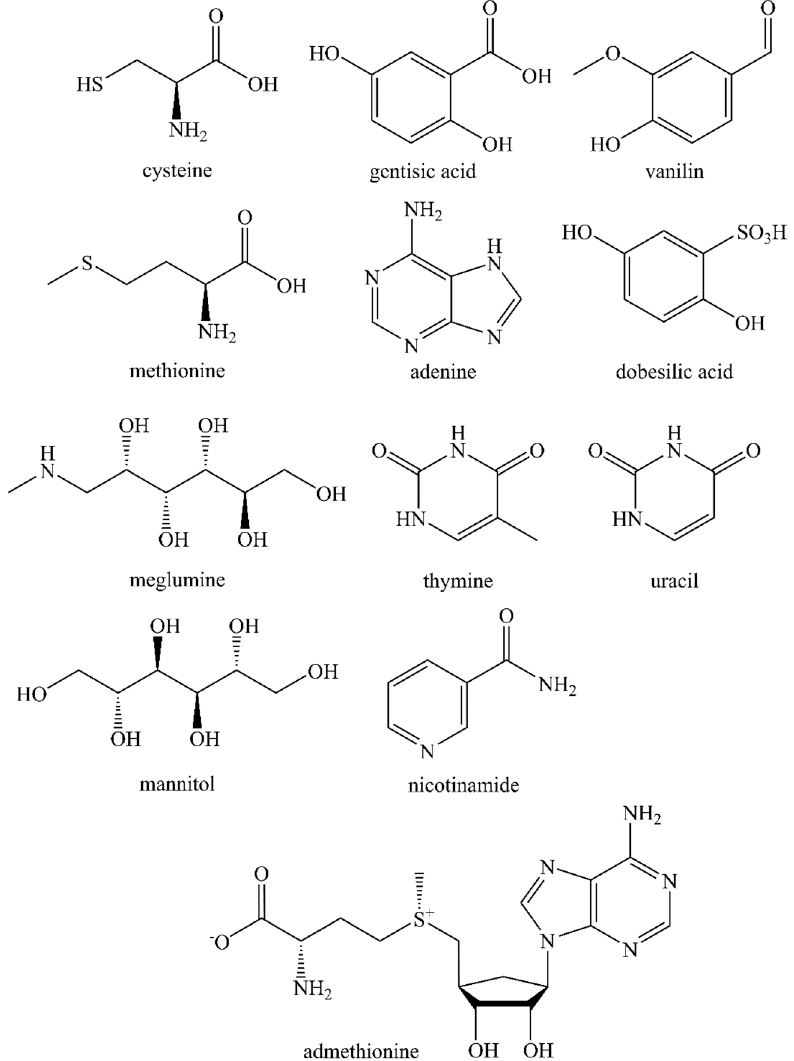
Figure 11. The molecules investigated as radical scavengers for [ 177 Lu]Lu-PSMA-617 preparations. The molar concentration of all the quenching excipients used was kept the same (7.4 μ M/mL) and was determined based on the maximum solubility in water of the least sol- uble compound (adenine, 1.003 mg/mL). None of the substances studied (in the indicated quantities) had any significant effect on the degree of lutetium-177 radiochemical conver- sion during [ 177 Lu]Lu-PSMA-617 synthesis. A comparison of the effectiveness of various quenchers against the radiolytic degradation of [ 177 Lu]Lu-PSMA-617 is presented in Fig- ure 12.